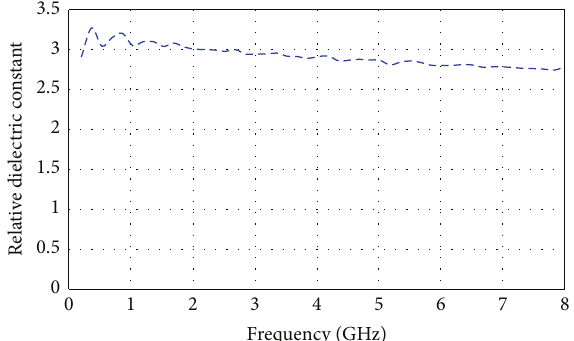
Figure 1: The variation of the dielectric constant with frequency for the canola